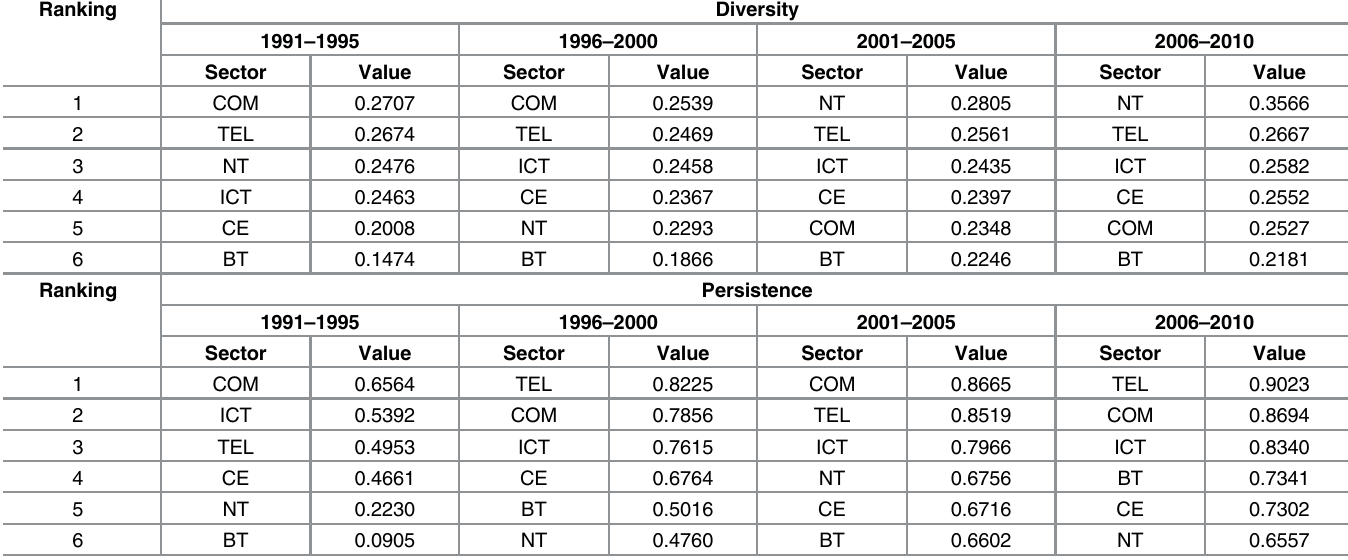
Table 10. Diversity and Persistence in ICT, BT, and NT Sectors in